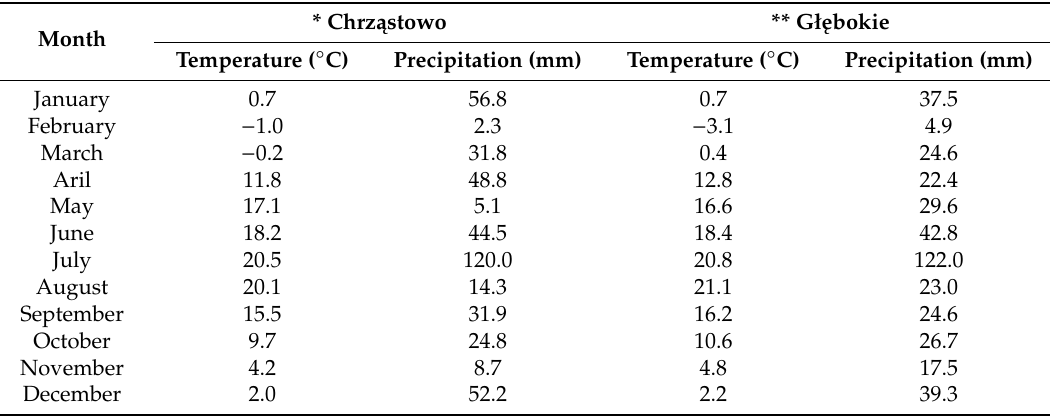
Table 1. Mean air temperature and amount of precipitation at the study